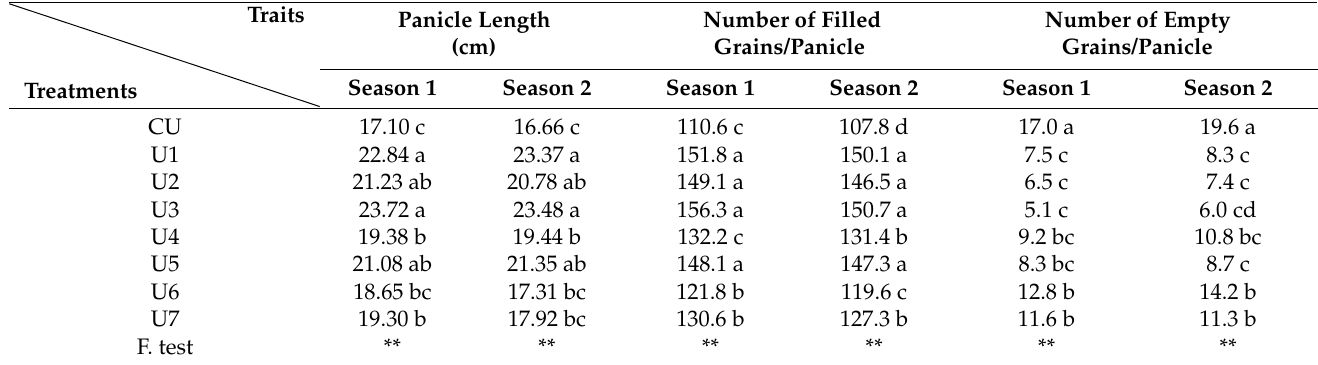
Table 6. Effects of different rates of classical urea fertilizer, urea chitosan nanohybrid and their combinations as an exogenous application on panicle length, number of filled grains/panicle, and number of empty grain/panicle of rice plants during the 2020 and 2021